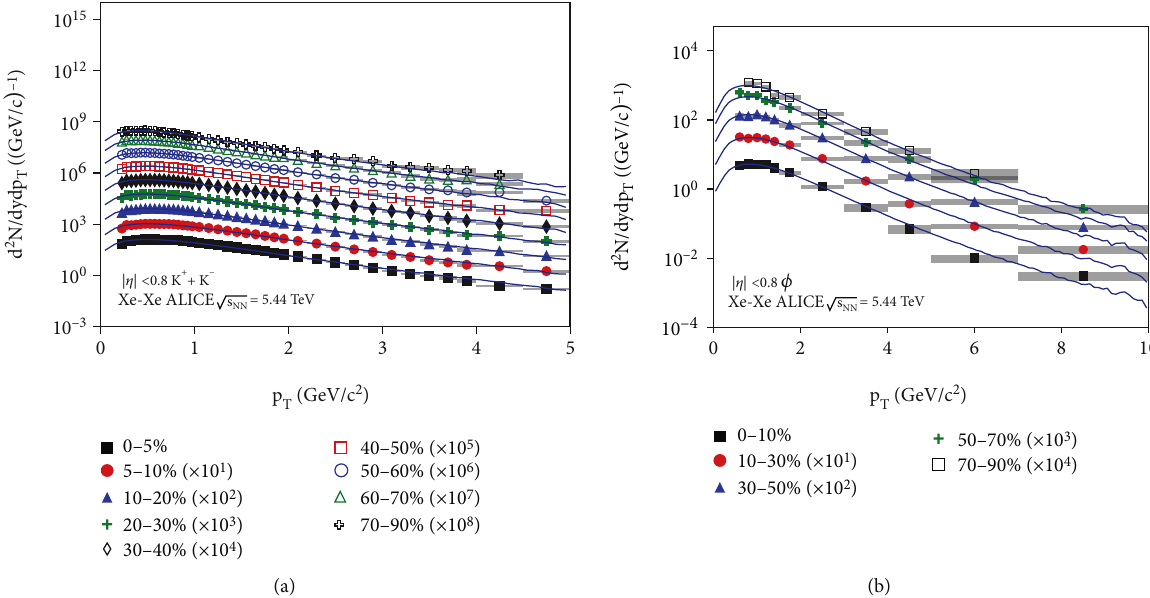
p ffiffiffiffiffiffiffi = 5 : 44 TeV. The symbols represent the data s NN